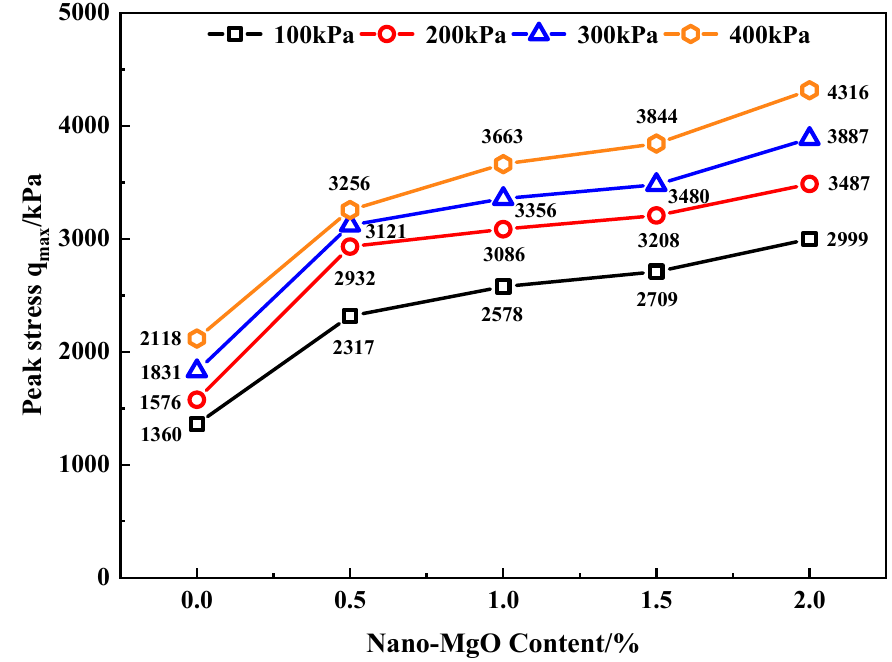
Figure 5. The relationship between peak stress and confining pressure of MCRA.